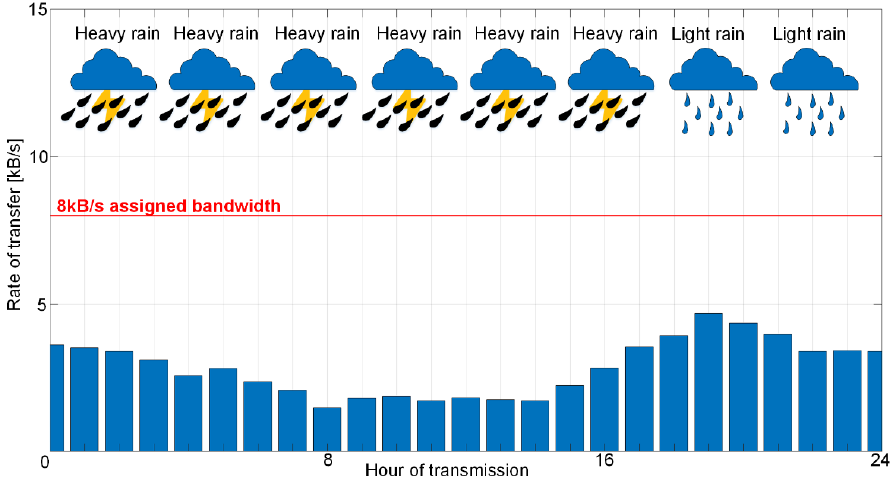
Figure 14. Transfer rate during bad weather conditions.